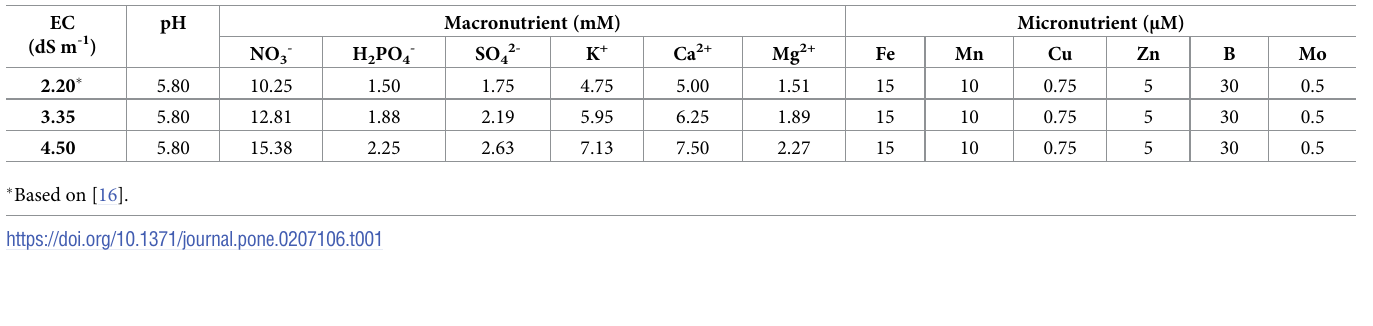
Table 1. Nutrient solution compositions for different